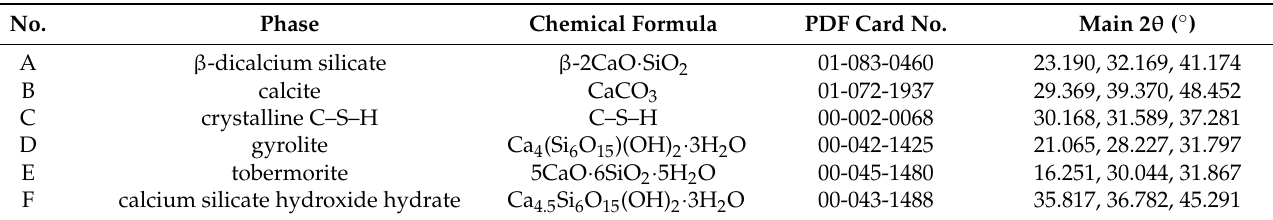
Table 2. Minerals phase information of hydrothermal synthesis of hydrated calcium